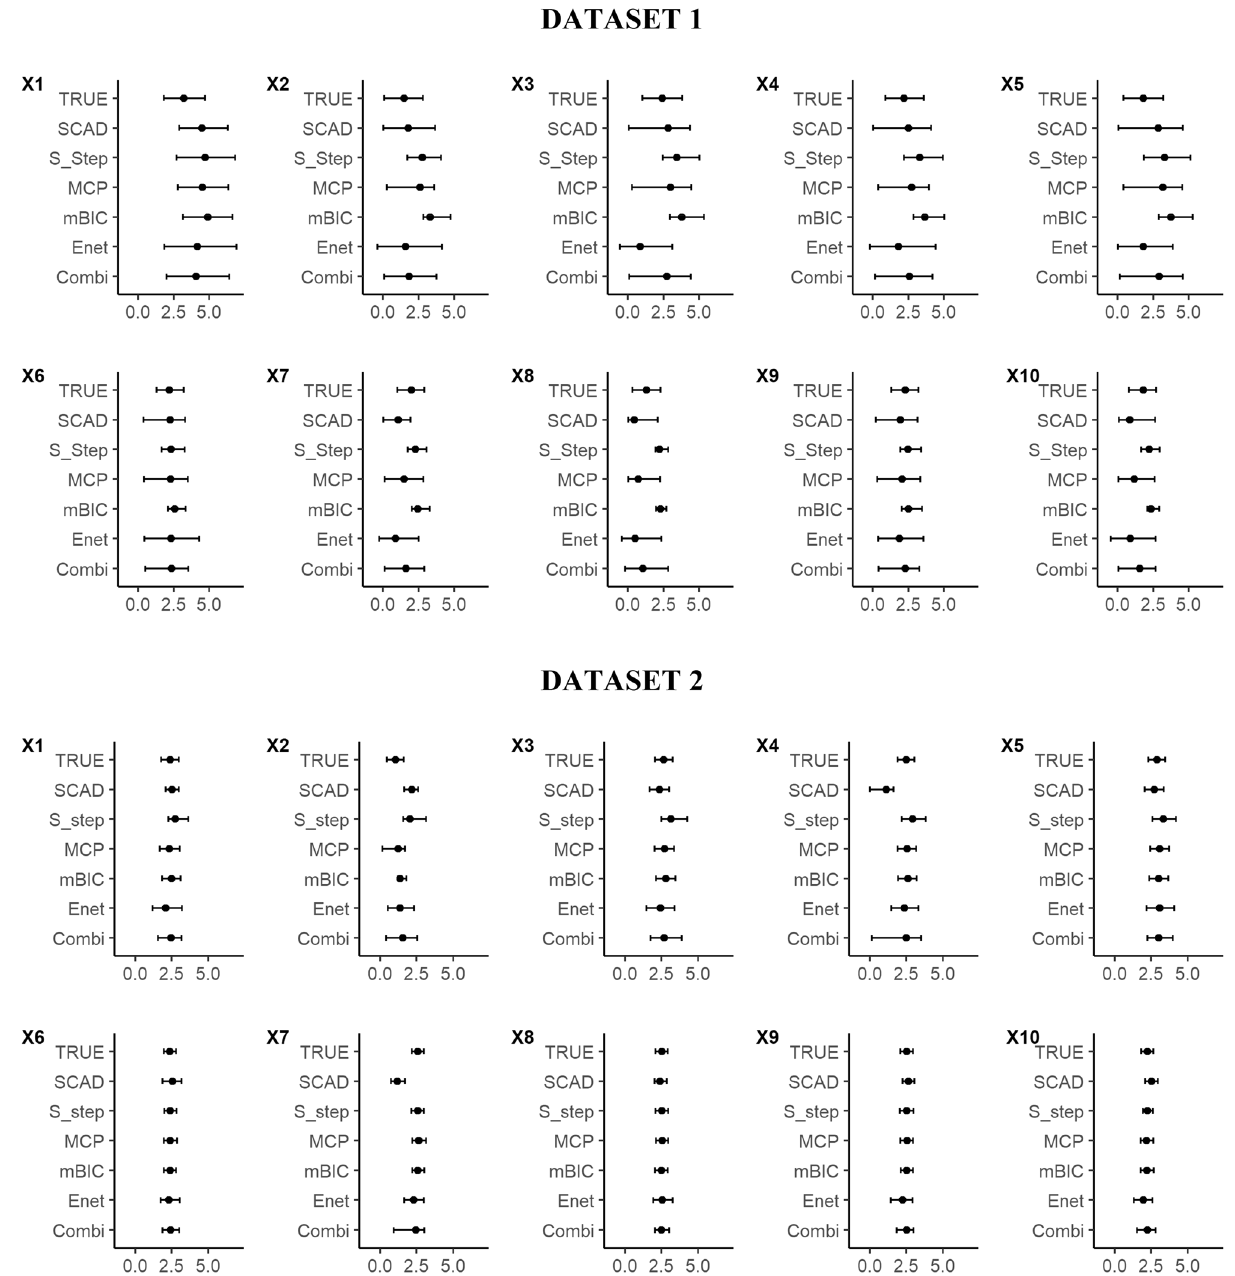
Figure 1. Bootstrap coefficient distributions of the true covariates in Datasets 1 and 2, estimated using five different statistical techniques and a combination method incorporating all five. ‘TRUE’ represents the actual underlying true partial coefficients. Key; X-axes – covariate coefficient value, X1 to X10 – covariate names, TRUE – the correct partial coefficient distributions for each covariate, SCAD – smoothly clipped absolute deviation, S_Step – SparseStep regression, MCP – minimax convex penalty, mBIC – modified Bayesian Information Criterion, Enet – elastic net regression, Combi – Combined method; results aggregated from all five